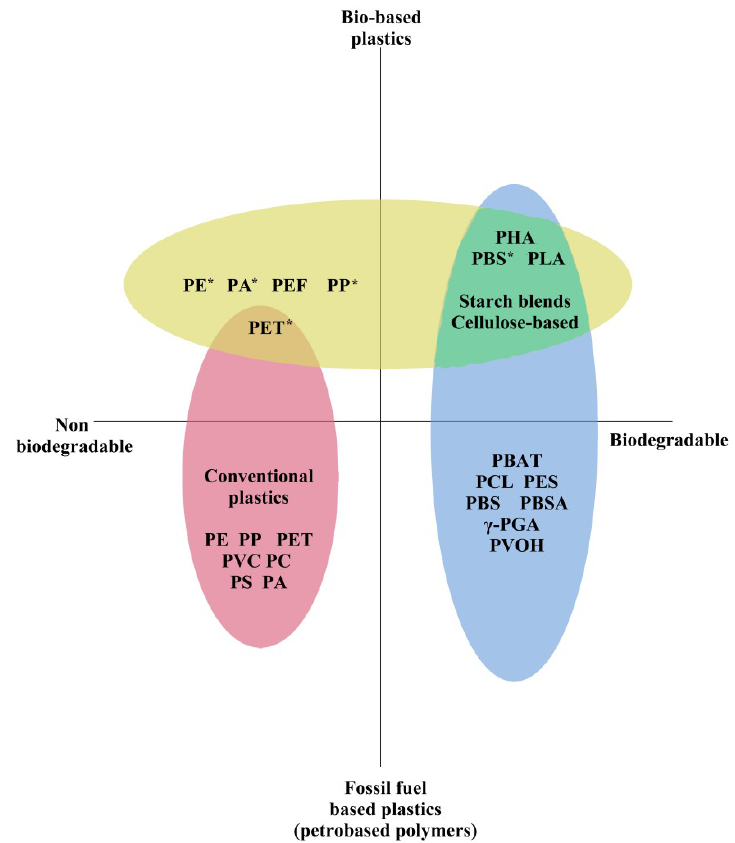
Figure 1. Plastics and bio-based polymers’ diversity and comparison diagram. Abbreviations include: PA—Polyamide, PBAT—Polybutyrate Adipate Terephthalate, PCL—Polycaprolactone, PE—Polyethylene, PEF—Polyethylene Furanoate, PES—Polyether Sulphone, Polyethylene Terephthalate—PET, PP—Polypropylene, PC—Polycarbonate, PHA—Polyhydroxyalkanoate, γ -PGA—Poly(Gamma Glutamic Acid), PLA—Poly(Lactic Acid), PS—Polystyrene, PBS—Poly(Butylene Succinate),